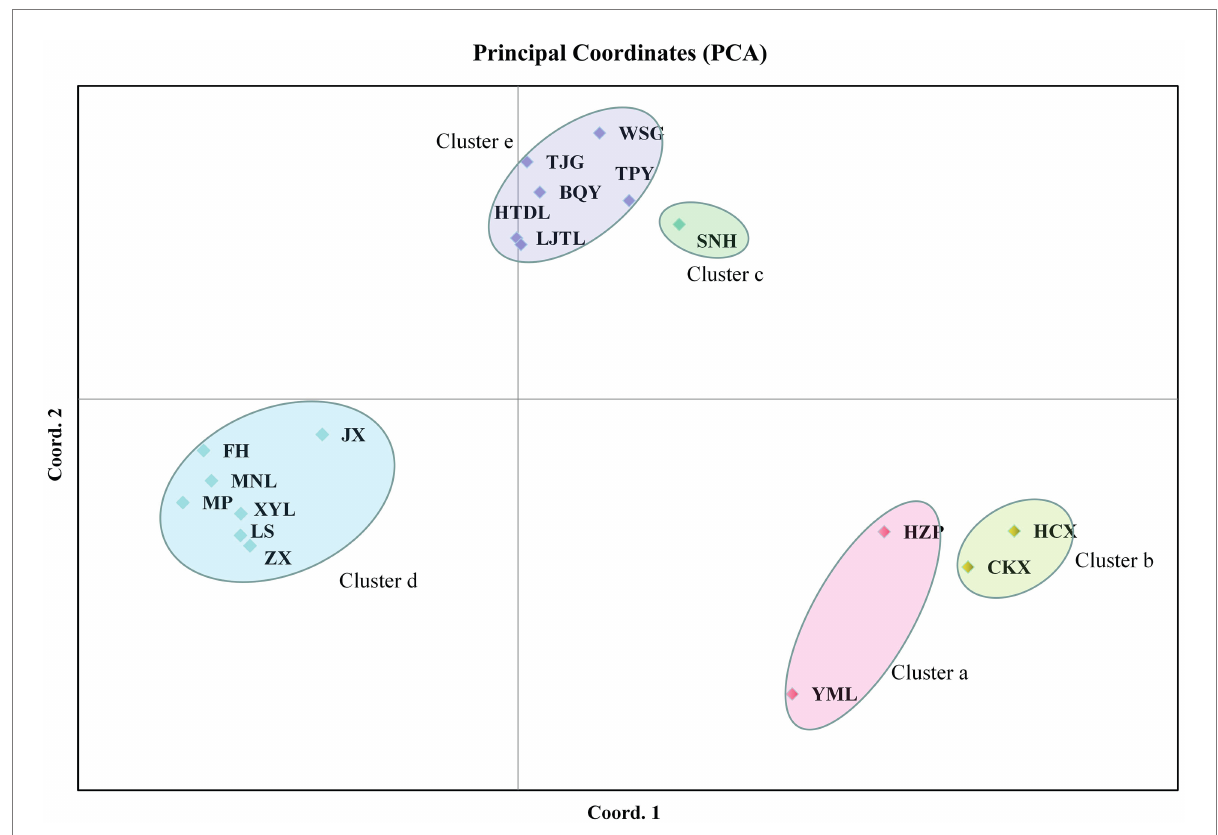
FIGURE 4 Principal component analysis (PCA) of the 18 tested populations based on ISSR and SRAP